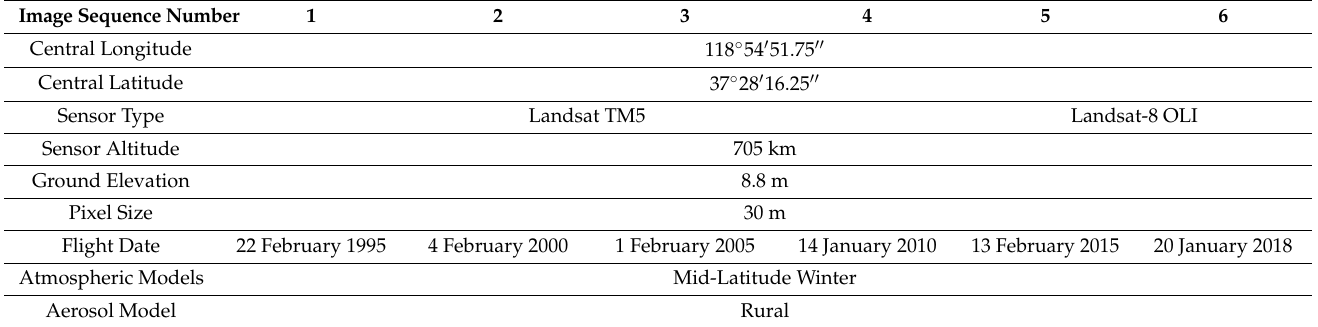
Table 1. Parameter setting of atmospheric